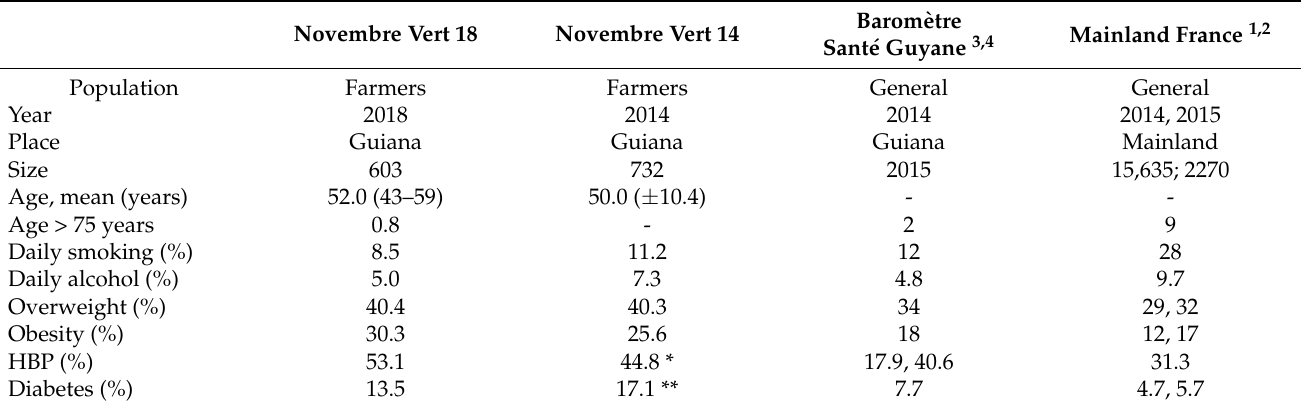
Table 3. Cardiovascular risk factors comparison between French Guiana (general population